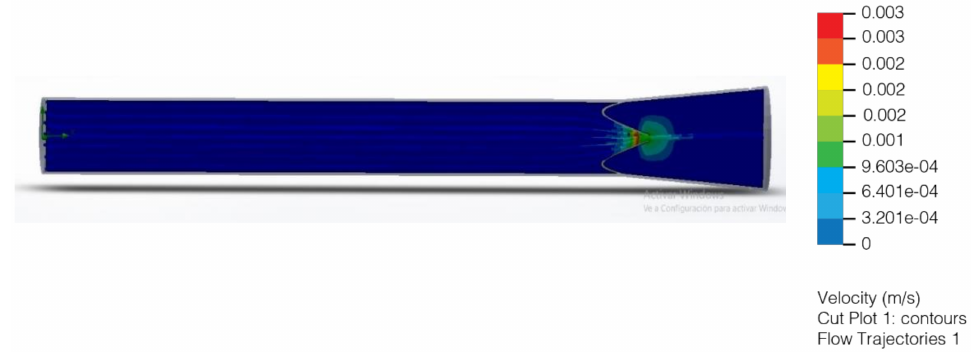
Figure 11. Flow of the liquid in relation to the speed in the inlet and the outlet valves (2020).